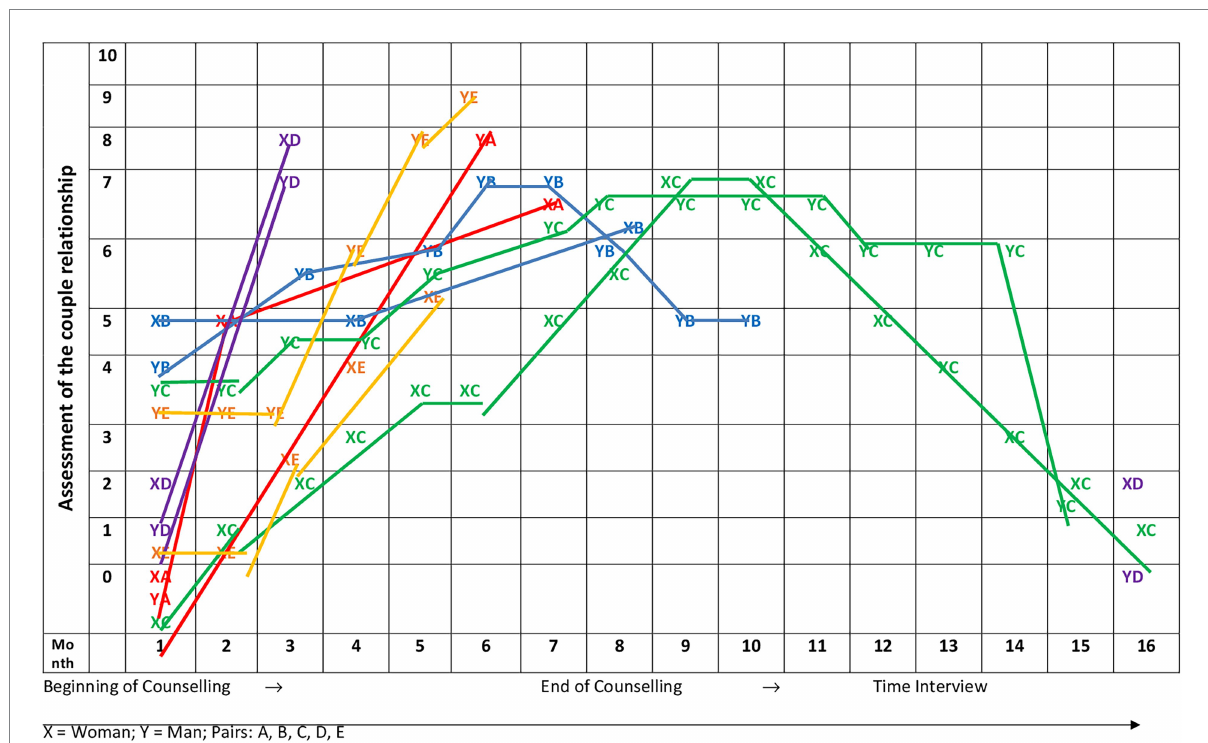
FIGURE 1 Satisfaction with the couple’s relationship step by step. From the beginning of the counseling session, over the course of time until the end of the counseling